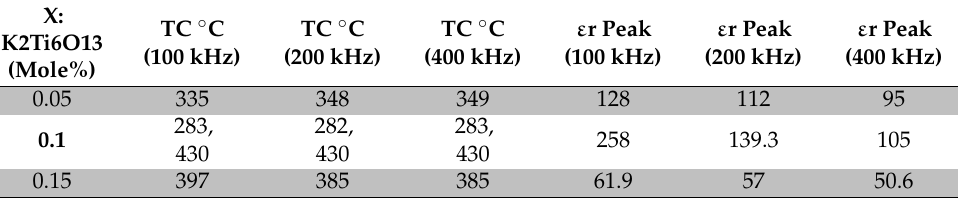
Table 2. Transition temperature and dielectric peak of Co x :K 2 Ti 6 O 13 ceramics at frequencies of 100 kHz, 200 kHz, and 400